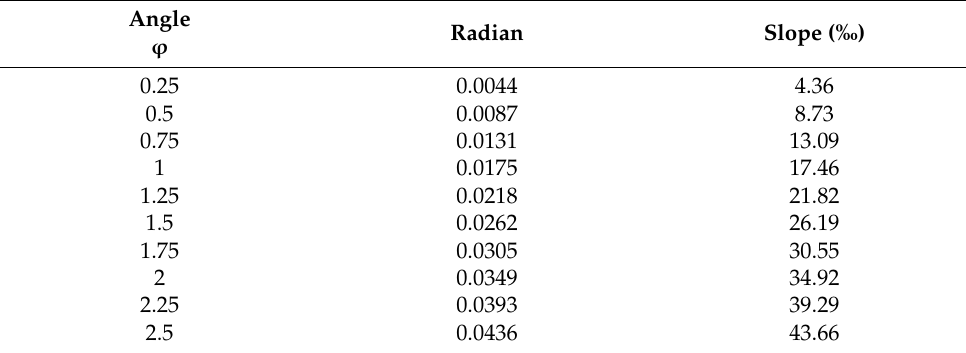
Table 2. The relationship between the pipe angle, radian, and slope.